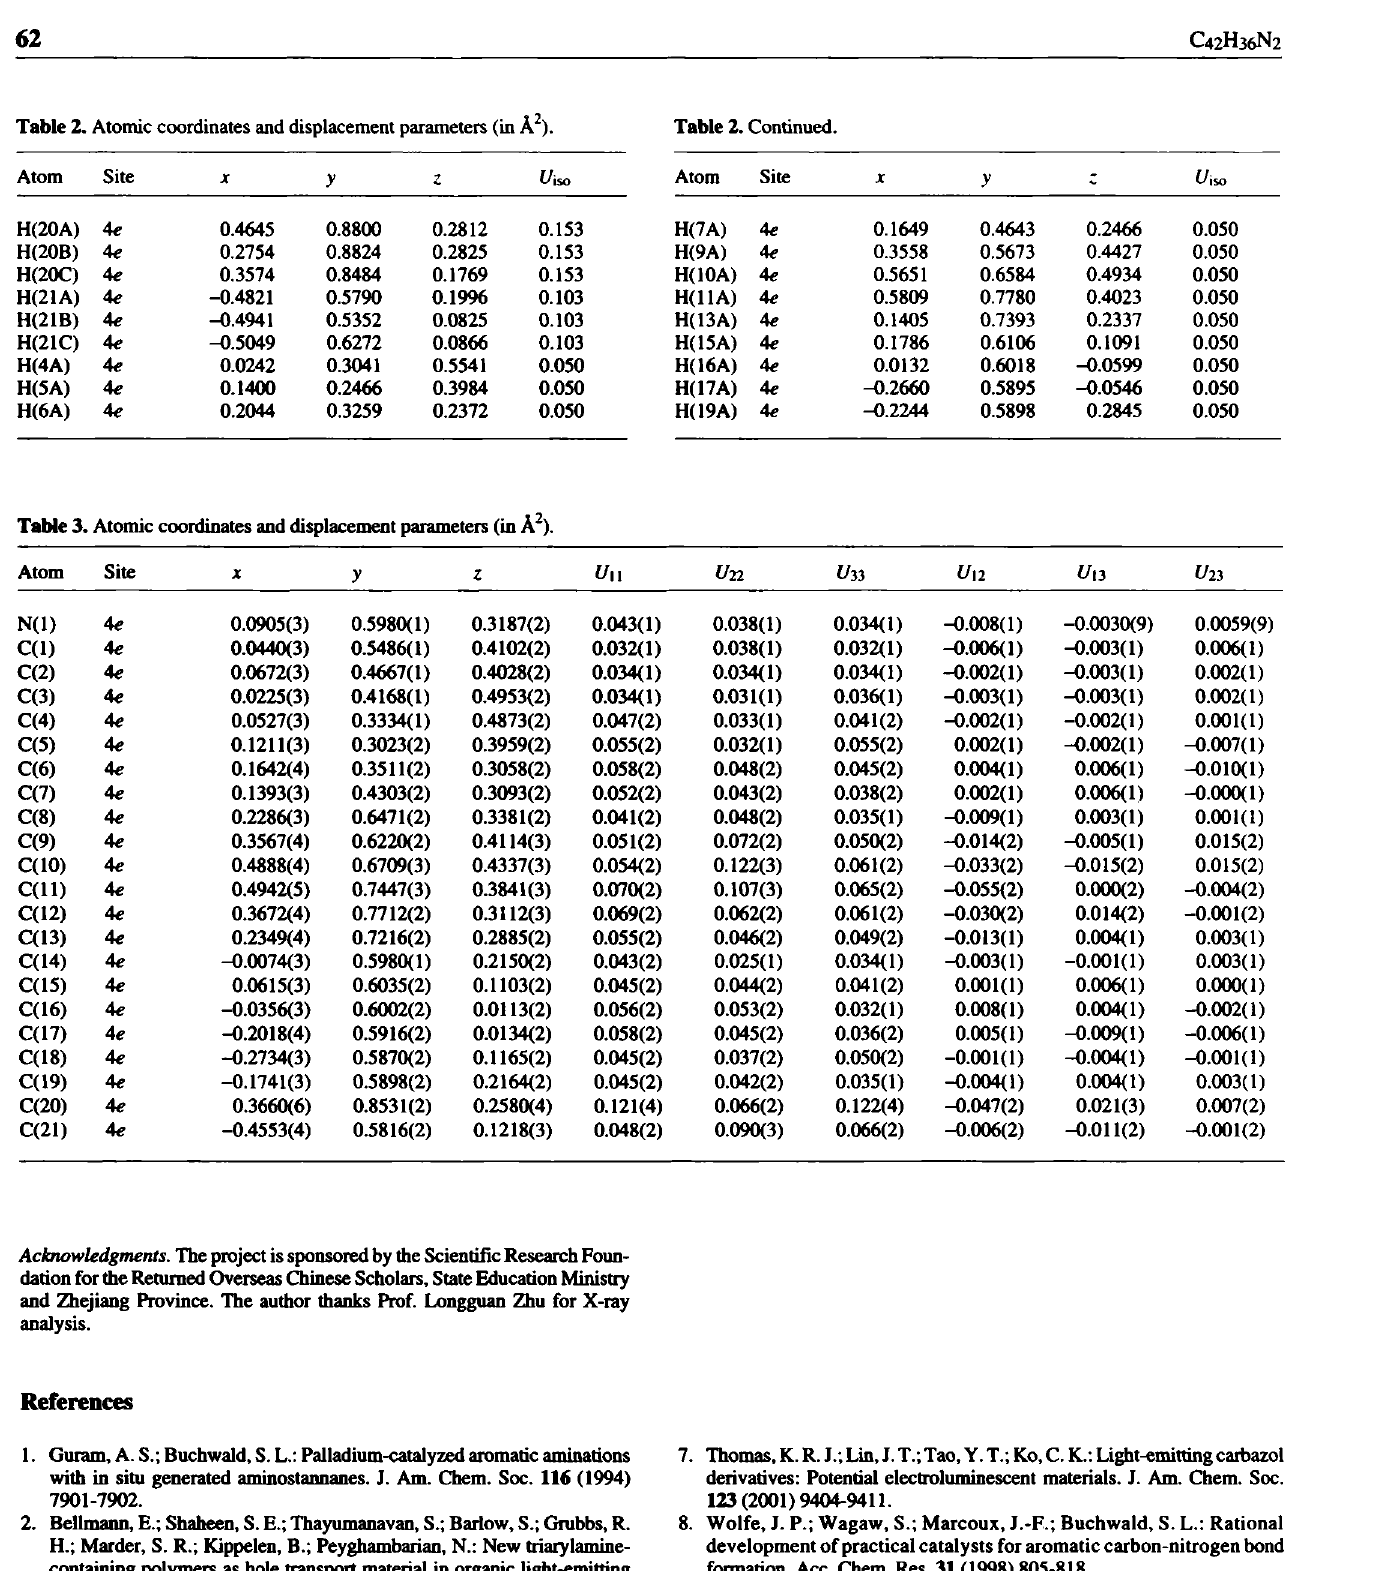
Table 2. Atomic coordinates and displacement parameters (in A 2 ).